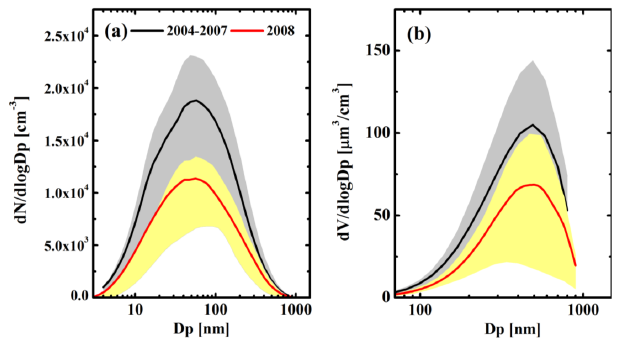
759 Fig. 3. Mean particle (a) number and (b) volume size distributions Figure 3: Mean particle (a) number and (b) volume size distributions in August from 2004 to 2007 (black line) and 760 in August from 2004 to 2007 (black line) and 2008 (red line). The 2008 (red line). The upper and lower boundaries of shaded areas indicate the 75th and 25th percentiles. 761 upper and lower boundaries of shaded areas indicate the 75th and 25th